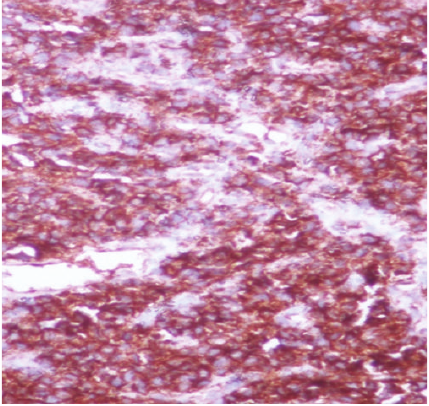
Figure 4: The figure shows CD99 positivity.